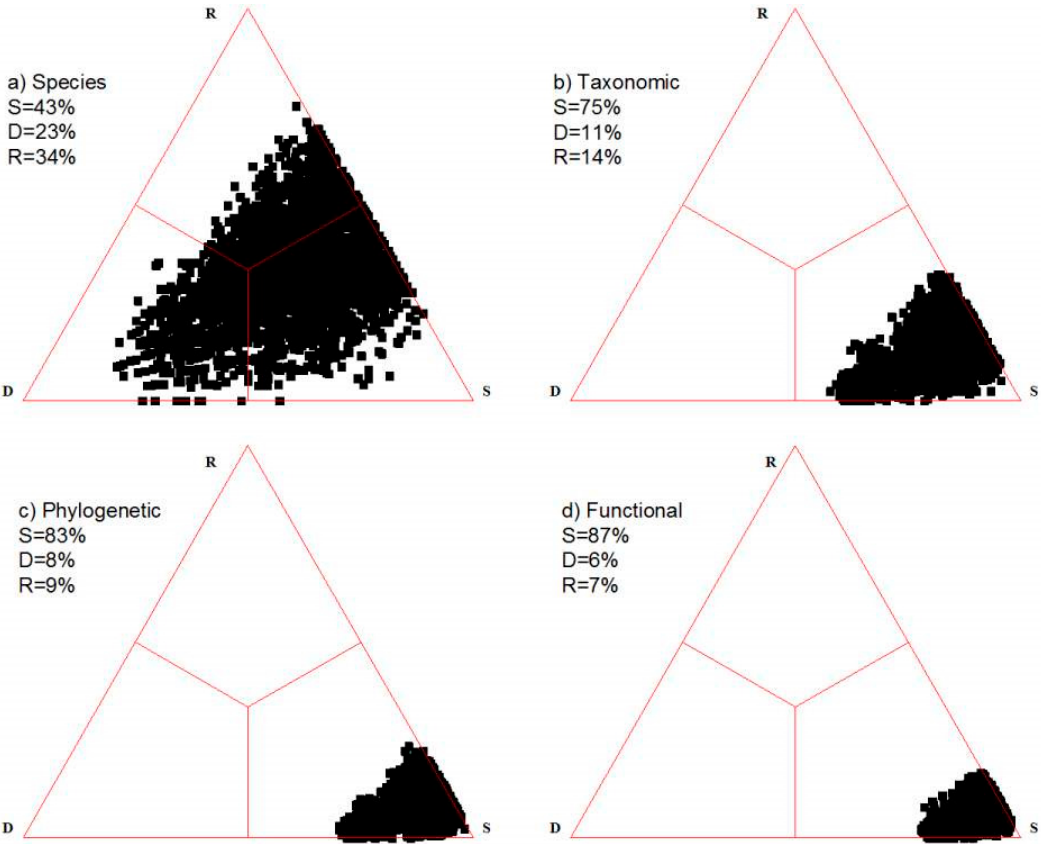
Figure 2. Four simplex diagrams for the Sas-hegy grassland data. Percentage scores refer to the respective centroids multiplied by 100. ( a ) Species; ( b ) Taxonomic; ( c ) Phylogenetic; ( d ) Functional.